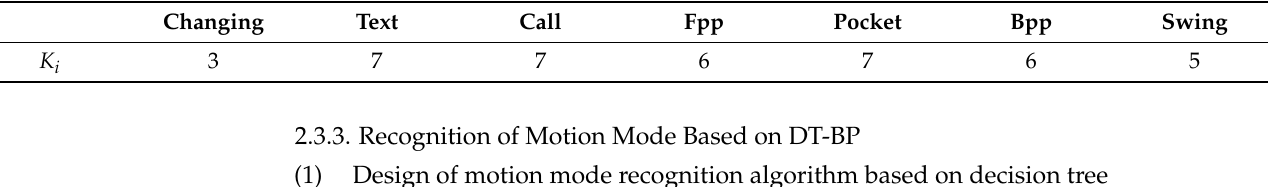
Table 4. Smartphone mode related feature quantity